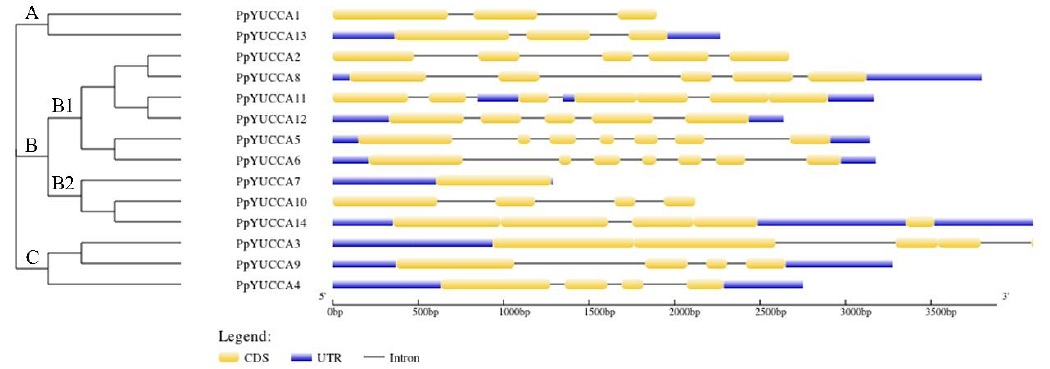
Figure 1. Chromosomal locations of Prunus persica var. pendula YUCCA genes. The scale represents a 50 Mb chromosomal distance.